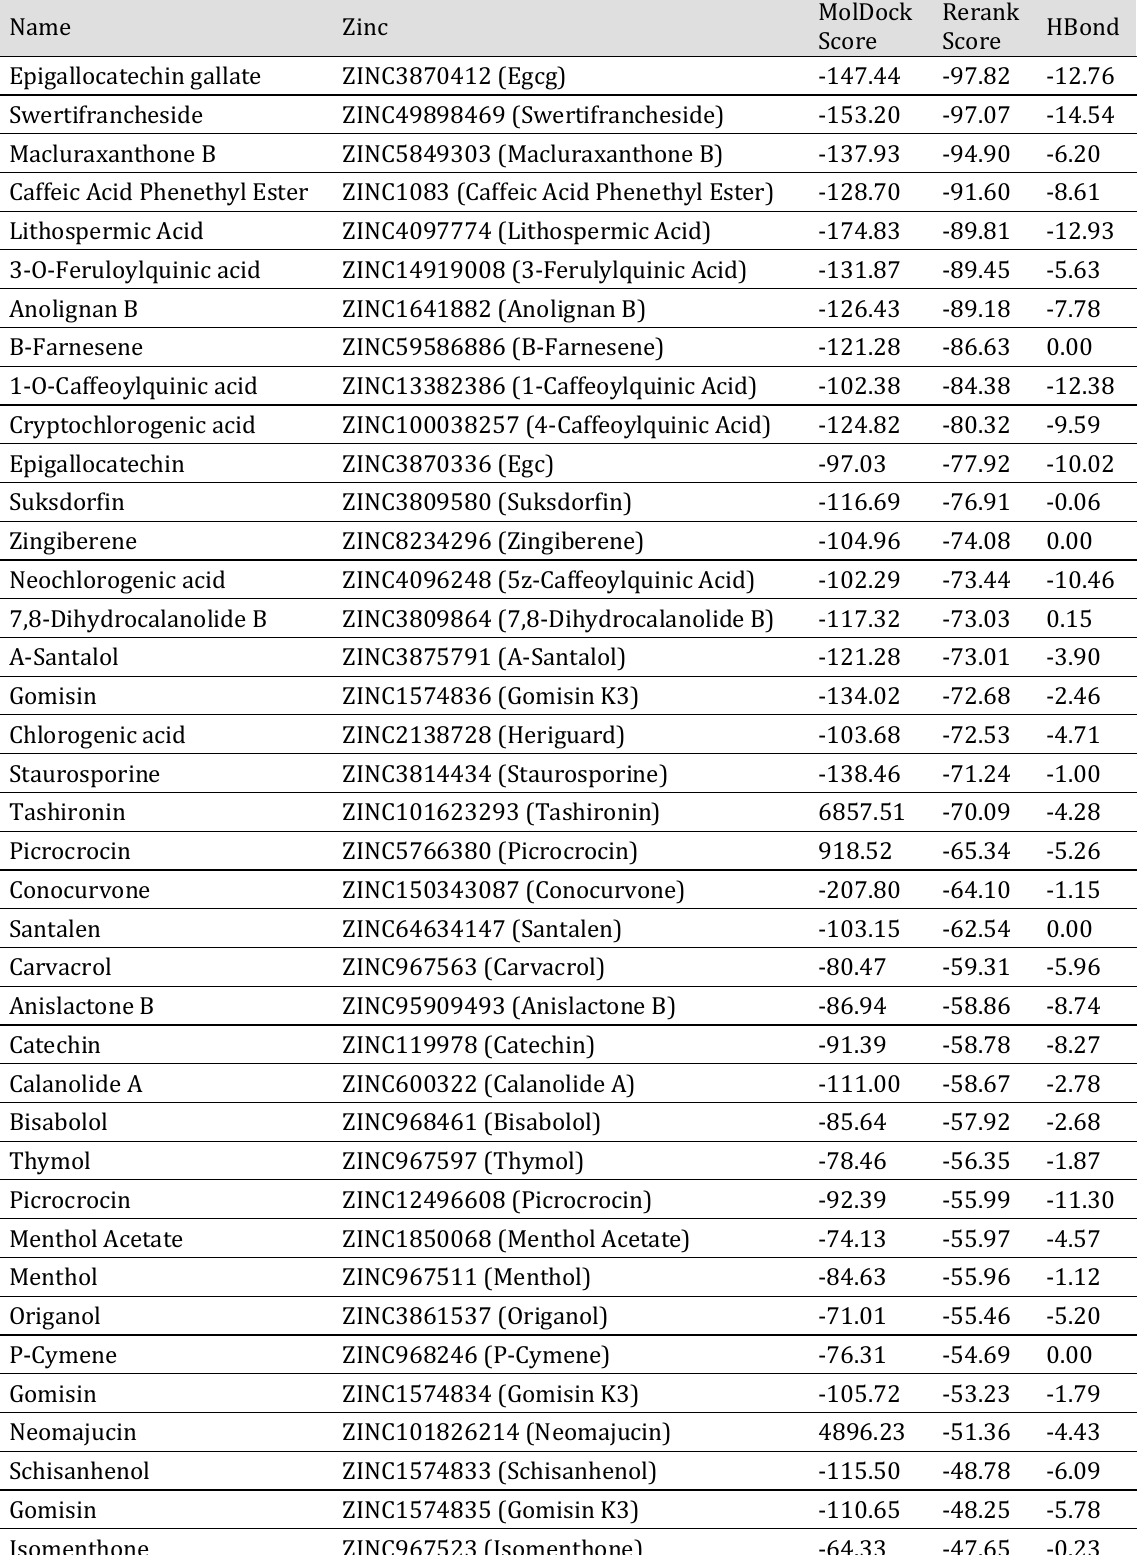
Table 5. The predicted poses scores of the rest inspected antiviral plant based